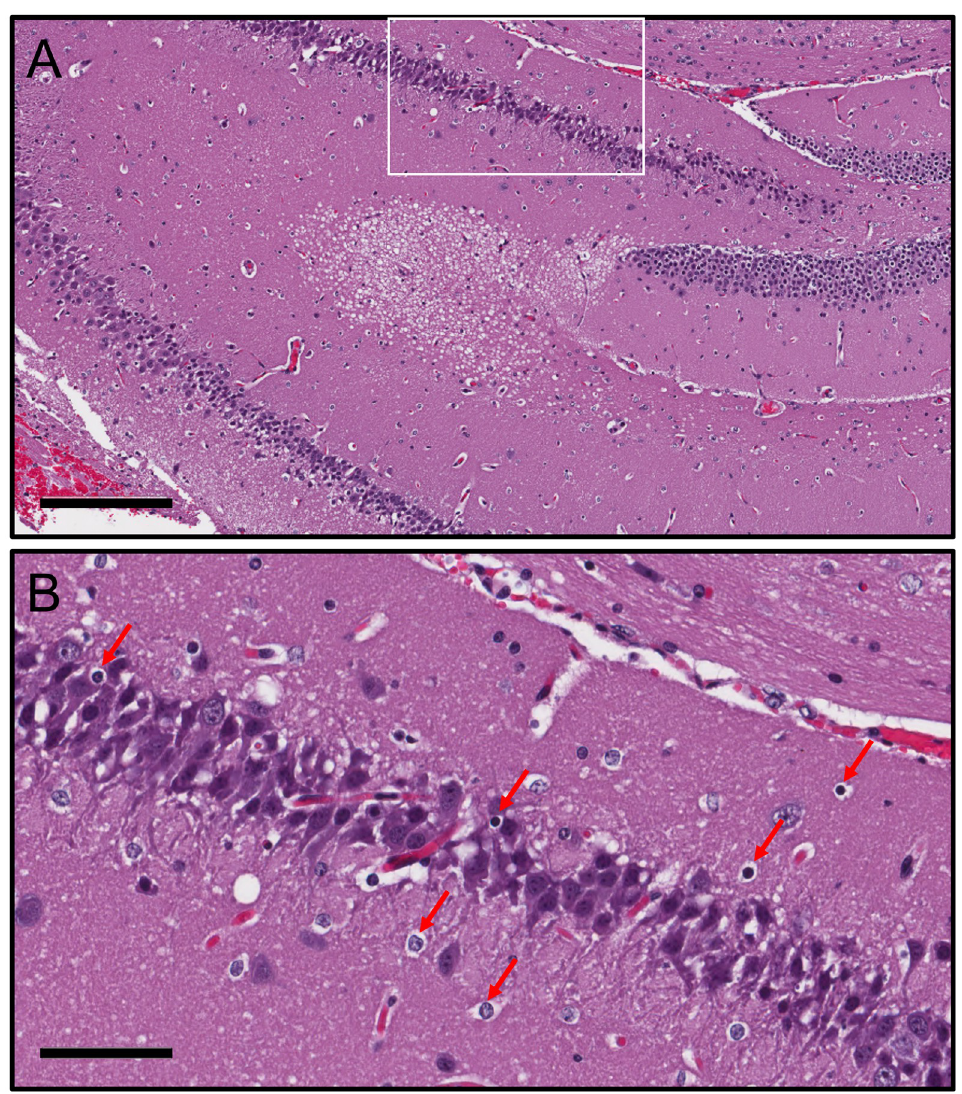
Fig 8. C . neoformans cortical infection progresses to hydrocephalus and causes neuronal apoptosis in the hippocampus. (A) Representative hippocampal section stained with H&E. Scale bar: 200 μ m. (B) Magnification of the white rectangle in A. Red arrows show apoptotic neurons in the CA3 region of the hippocampus. Scale bar: 60 μ m. Five mice per infection route were evaluated to confirm all the histopathological observations reported in these studies. matter, degeneration and demyelination of the nerve fibers, and recruitment of gitter cells (Fig 9E) in the presence of erythrocytes (black arrows; Fig 9F). Hemorrhage in the margins of a cryptococcoma (rectangle box; Fig 9G) shows extensive aggregation of gitter cells around the bleeding area and cryptococcal brain lesion (Fig 9H). High power magnification confirmed significant gitter cell recruitment (blue arrows) into the hemorrhage region (Fig 9I). i.c. C . neo- formans infection of the striatum results in extensive encephalomalacia, multiple hemorrhage foci (Fig 9J), and considerable aggregation of polymorphonuclear cells around the blood ves- sels and in the lesion (Fig 9K–9L). A coronal section of mice infected with C . neoformans show multiple cryptococcomas scattered in the posterior limb of internal capsule, the putamen